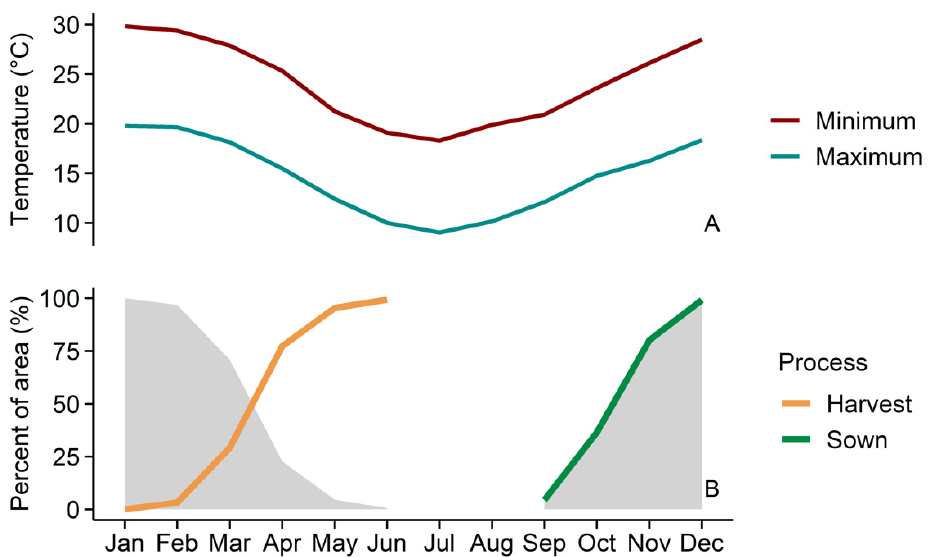
Figure 11. ( A ) Monthly average minimum and maximum temperatures from 2000 to 2019 (Source: Dados da Rede do INMET [73]), ( B ) Average harvest and planting activity in the Rio Grande do Sul state, Brazil between 2010 and 2019 (Source: IRGA [74]). The shaded area represents the percentage of Rio Grande do Sul State (largest rice producer in Brazil) acreage with rice crop progression from initial establishment (sowing starting in Sep.) to final harvesting (end of